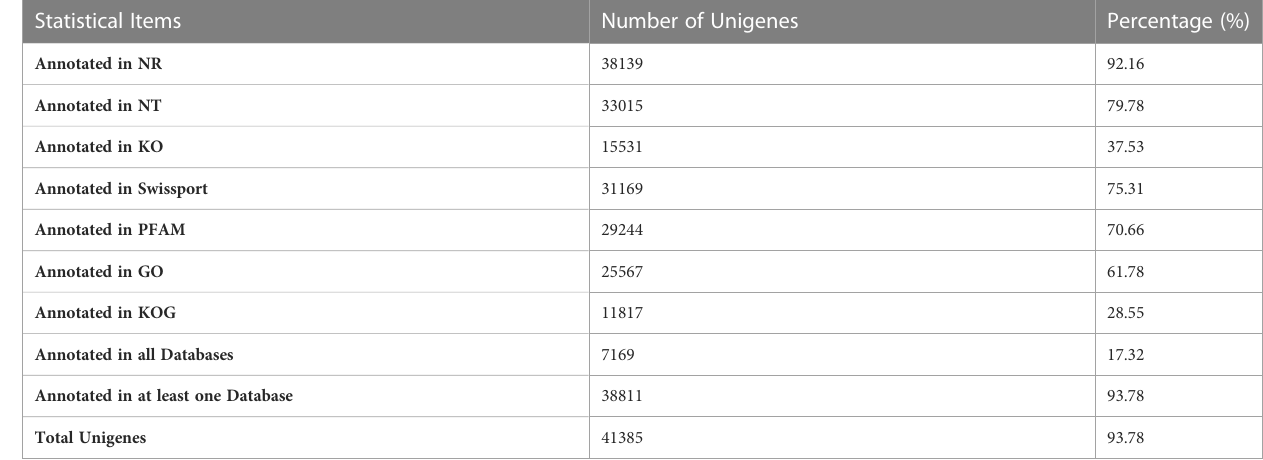
TABLE 1 The ratio of successfully annotated